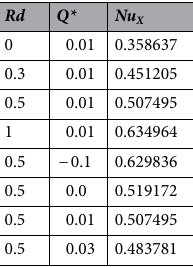
Table 3. Local nusselt number for various